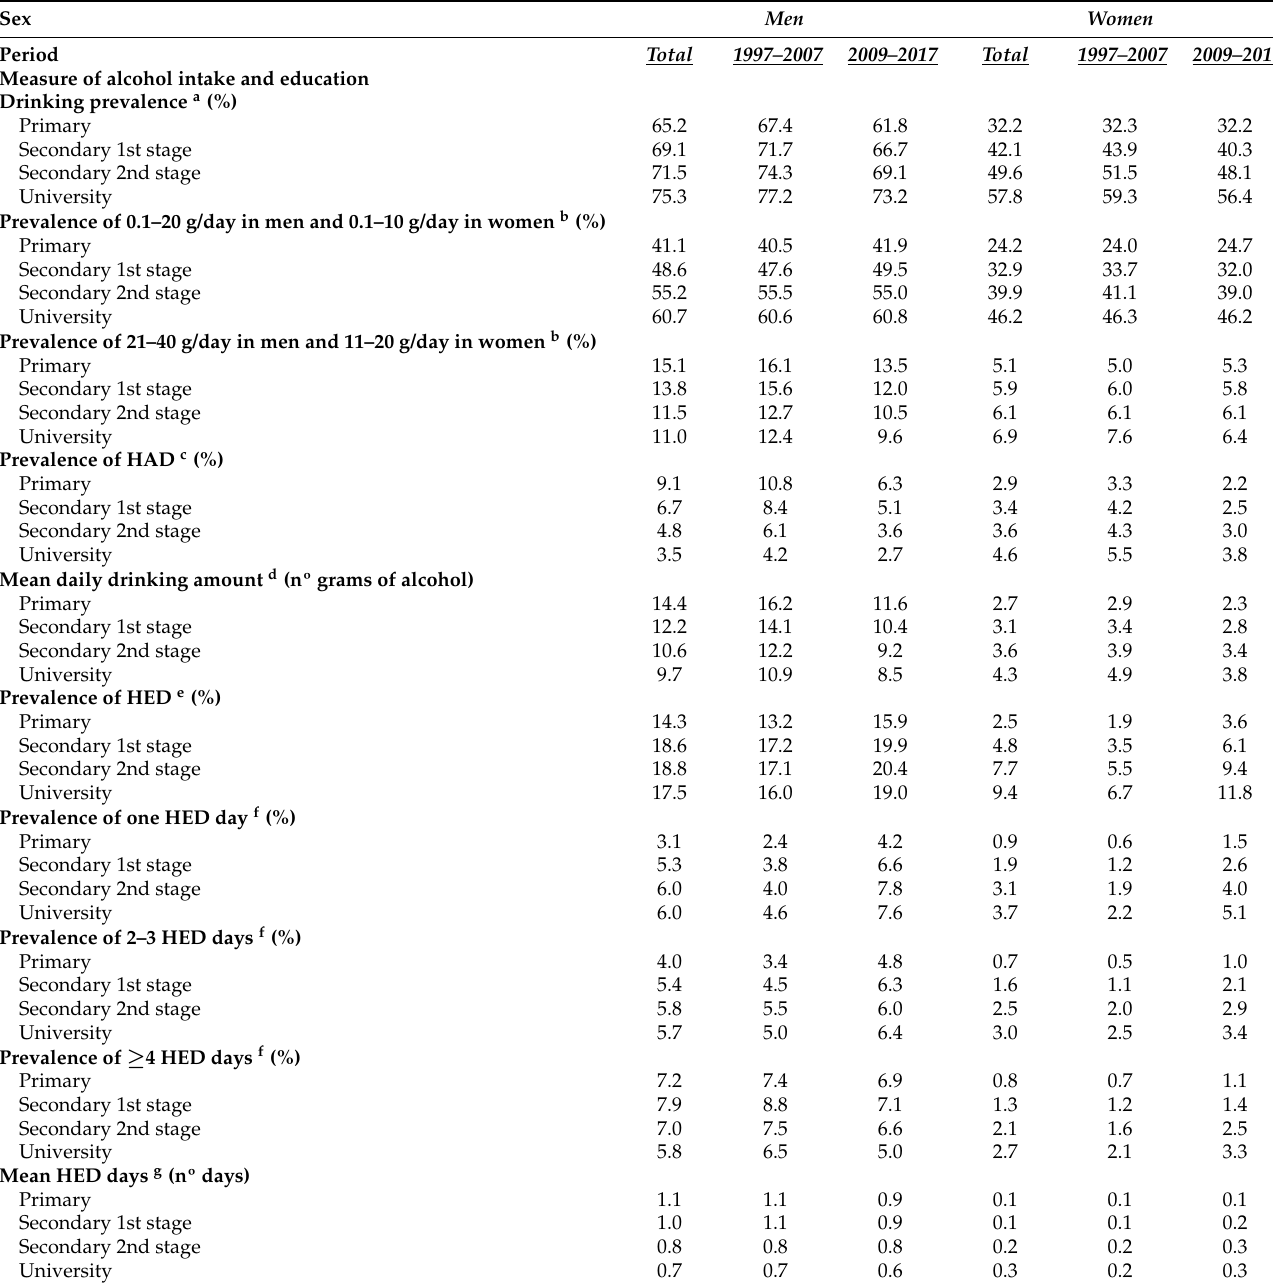
Table 1. Crude drinking measures in last 30 days among population aged 25–64 by sex, period and education level, Spain